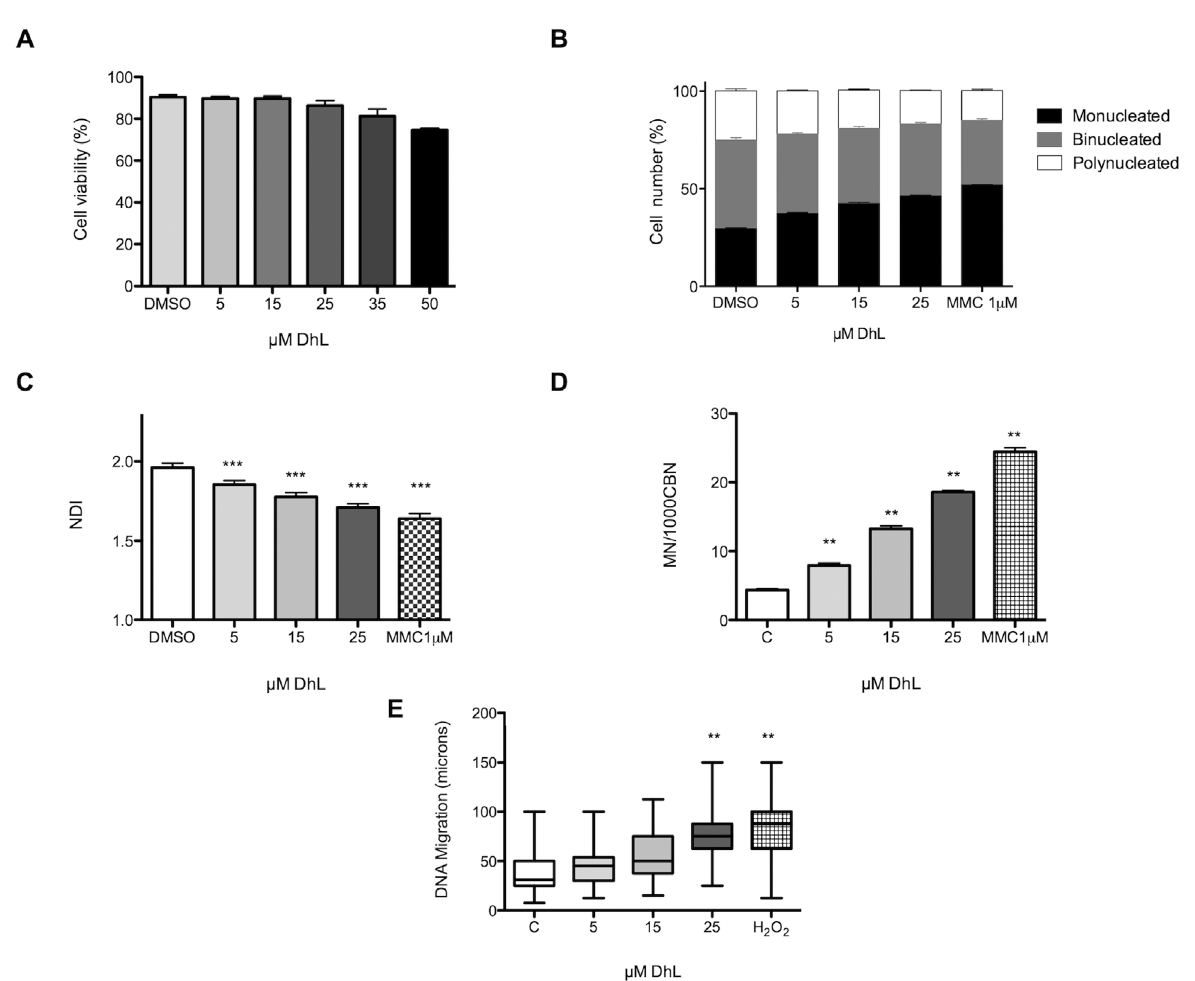
Fig 6. DhL induced cytostatic and genotoxicity effects in human lymphocytes. Lymphocytes were exposed to DhL (5, 15, 25, 35 and 50 μ M). (A) Cell viability assay. (B) Proliferation kinetics of lymphocytes. (C) Nuclear division index (NDI) assay. The fraction of monucleated (black bars), binucleated (grey bars) and polynucleated (white bars) cells are shown. ANOVA-Dunnet: * p < 0.005, ** p < 0.001, *** p < 0.001. (D) Micronucleus frequency (MN) on binucleated cells. As a reference, we used lymphocytes treated with 1 μ M Mitomycin C (MMC) (square bars) ANOVA-Dunnet: ** p < 0.001. (E) Comet assay. The tests for significance were limited to the Kruskal – Wallis one-way ANOVA-Bonferroni on ranks. ( ** p < 0.001). The data are represented as the mean ( ± SEM) of three duplicated experiments from three